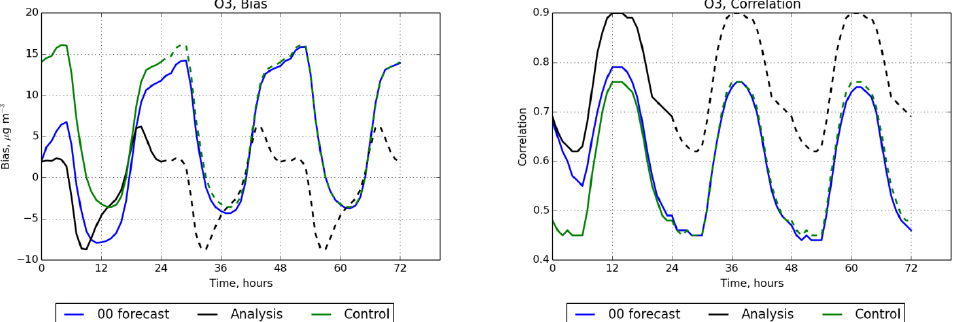
Figure 7. The model bias (µgm − 3 ) and correlation for O 3 at the MACC validation stations as a function of forecast length (blue lines). The corresponding indicators, the analyses (black) and control run (green), are shown averaged by time of day and replicated over the forecast window.